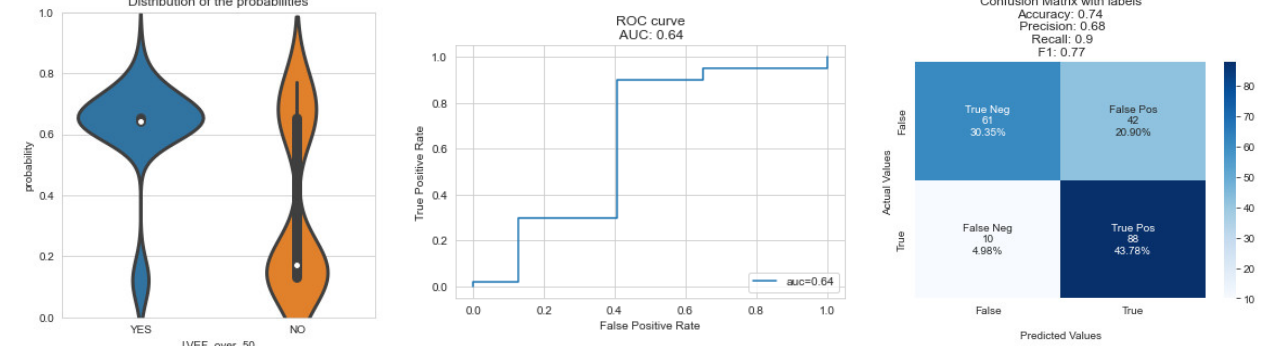
Figure 3. Classification results for behavioral variables.